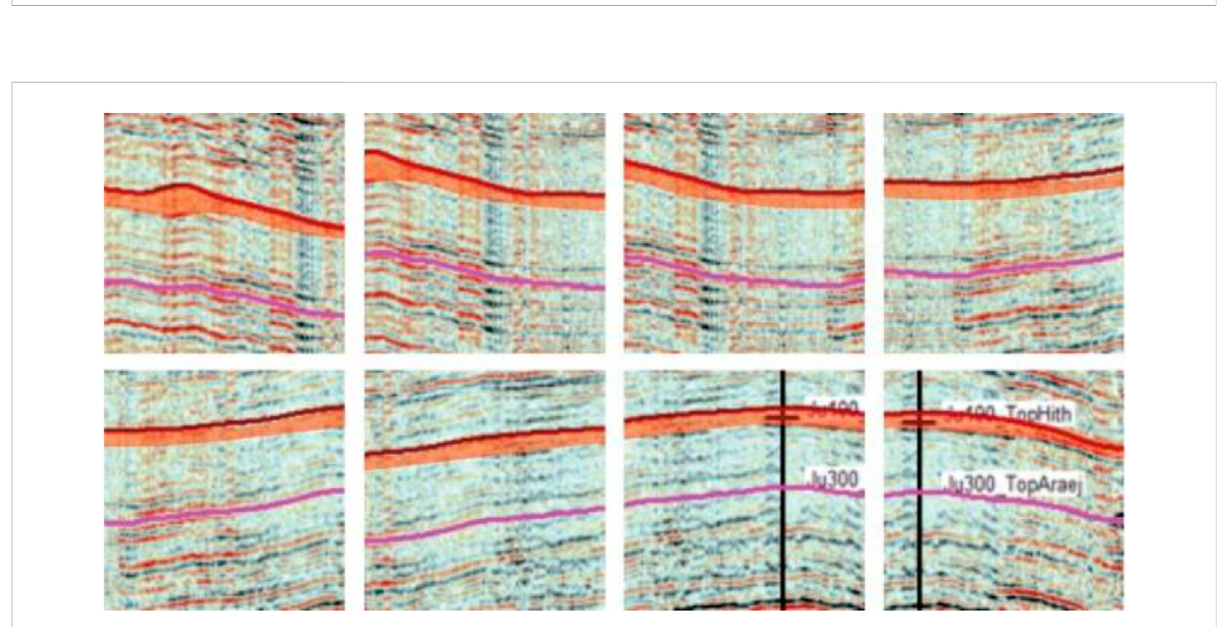
FIGURE 14 Thesaltidenti fi cationina fi eldof100×100pixels(everyimageisthepredictionbythemodelfromstage5;Theorangepartistheidenti fi